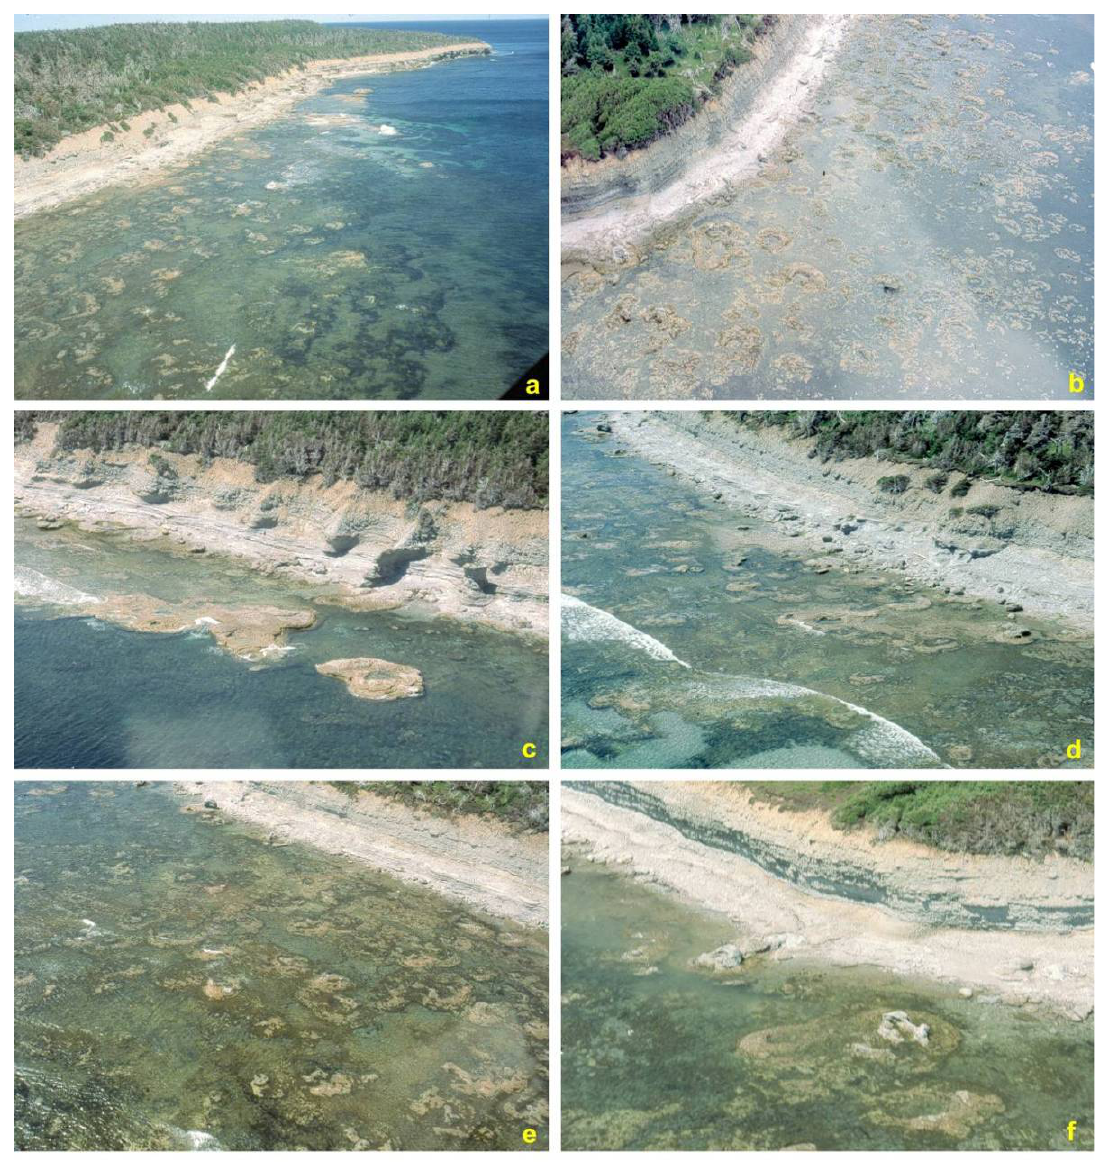
Figure 4. Helicopter views East Point reef outcrops. ( a ) panoramic shot of the reef outcrops on the tidal flats, looking WNW towards Goéland cliffs: in the distance the reefs are shown within the cliff exposures; ( b ) reefs on the tidal flats in the area close to East Point, shown at partial low tide; ( c ) bluff and lower level exposures of the East Point reefs ca. 1 km W of East Point: note that the reefs were developed discontinuously at several levels through the 12–13 m thickness of the member; ( d ) reefs on the tidal flats at the western end of the reefal outcrops, some subtidally submerged and some close to low tide level; ( e ) Over 20 reefs exposed at low tide, with some displayed within the adjacent bluffs; ( f ) about eight reefs exposed on the tidal flats, with further reefs in the middle and upper East Point